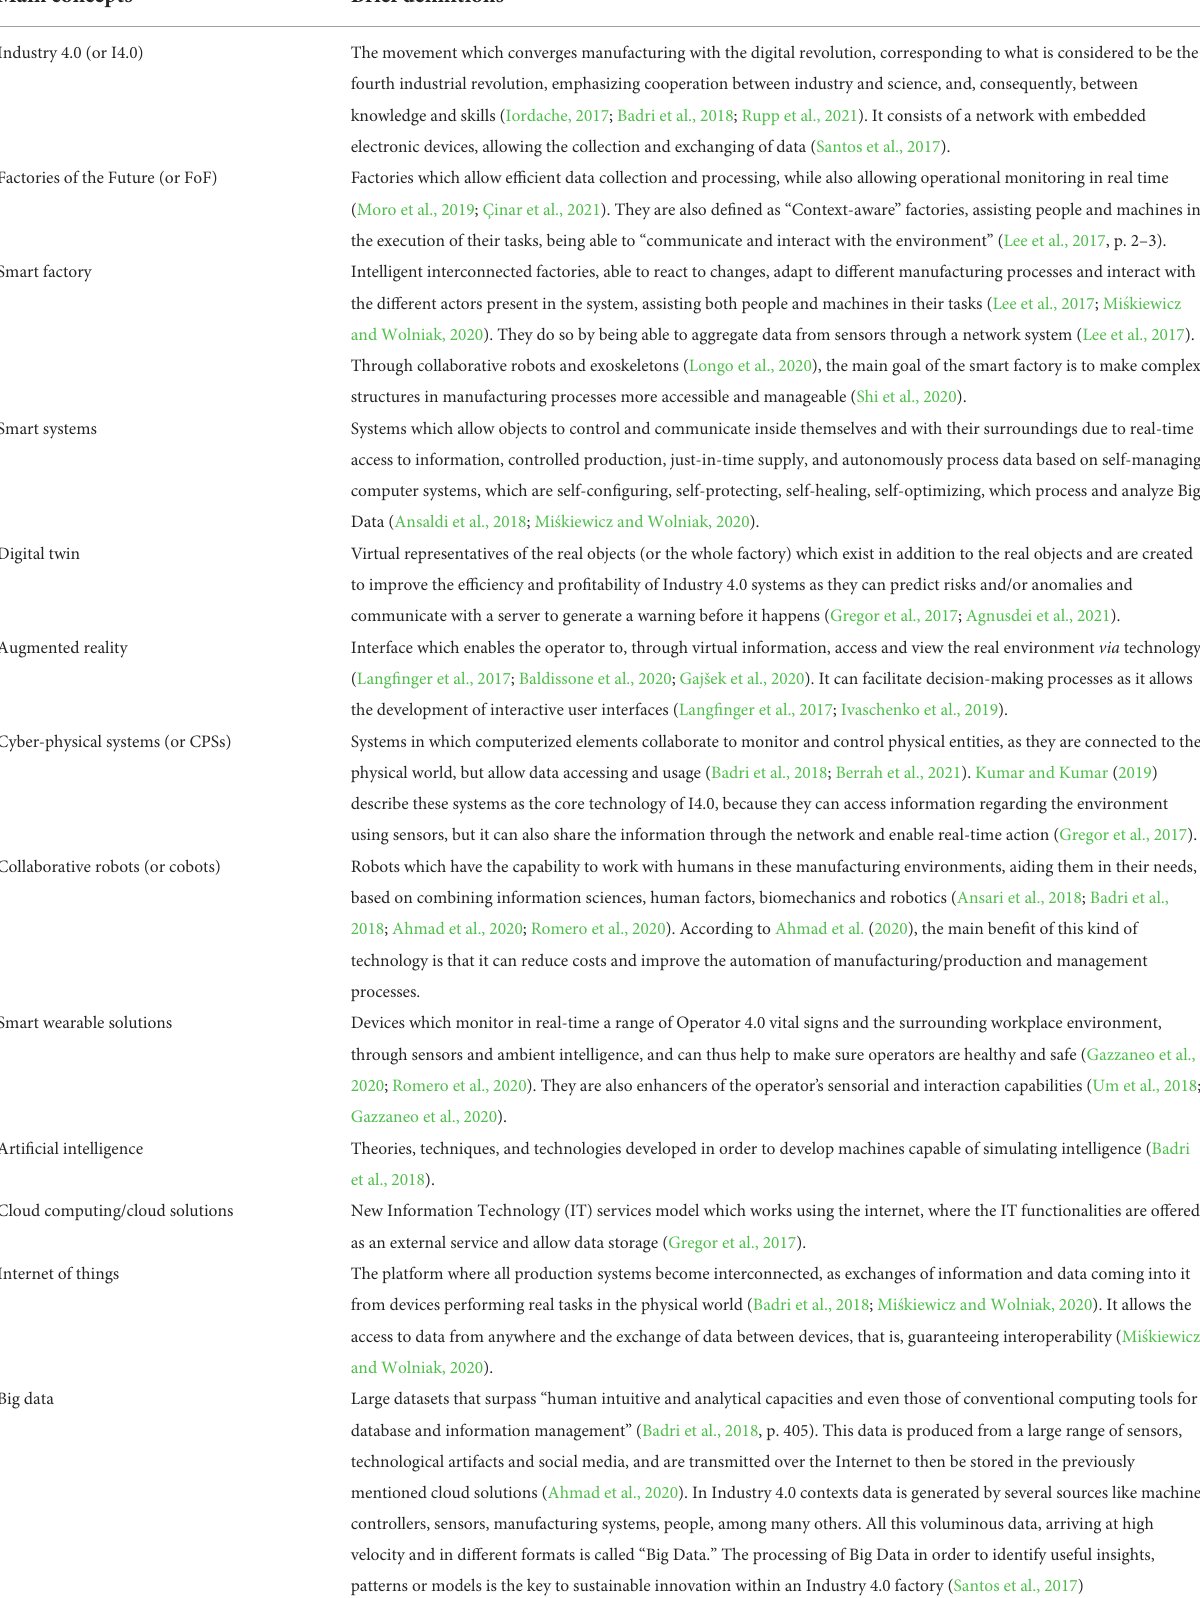
TABLE 3 Synthesis of the main Industry 4.0 related